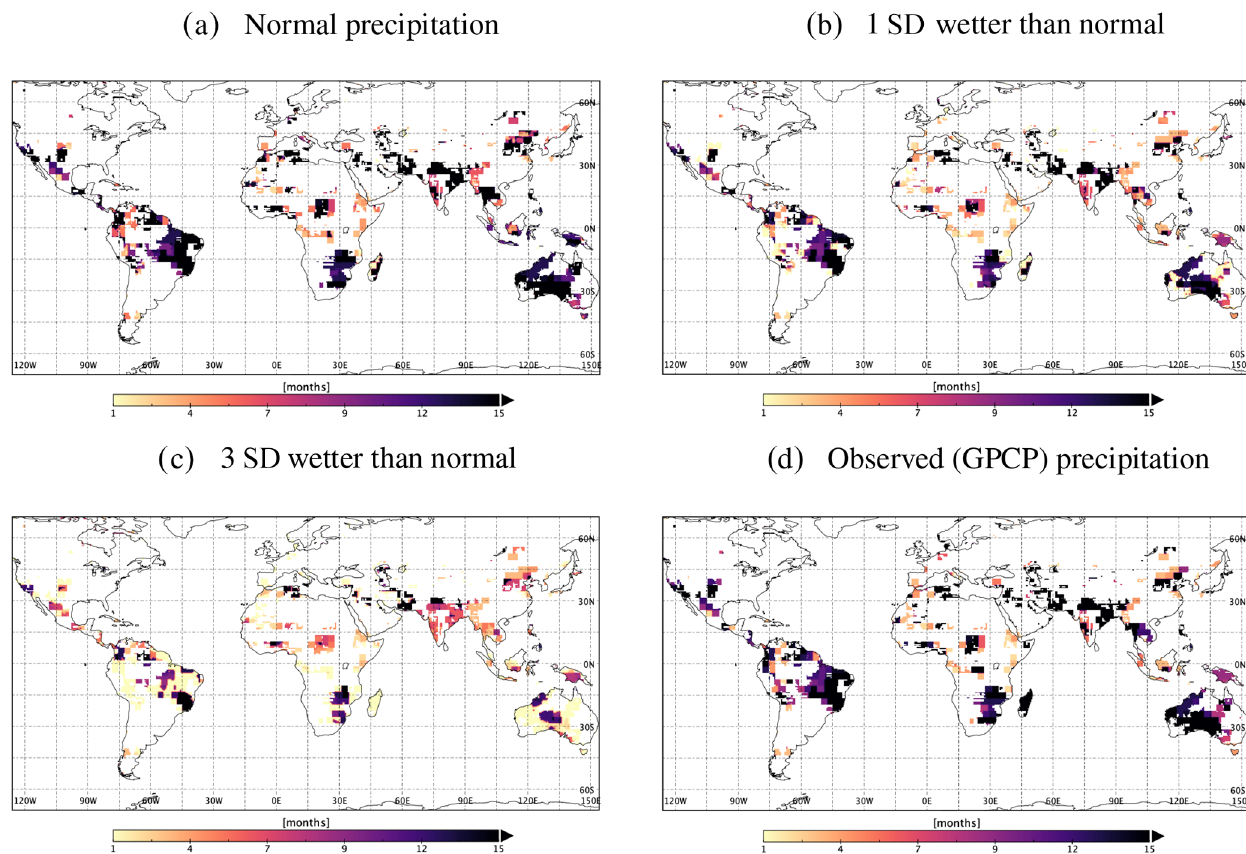
Figure 10. Duration of drought recovery from January 2016, given the three different precipitation scenarios, as observed by GRACE.